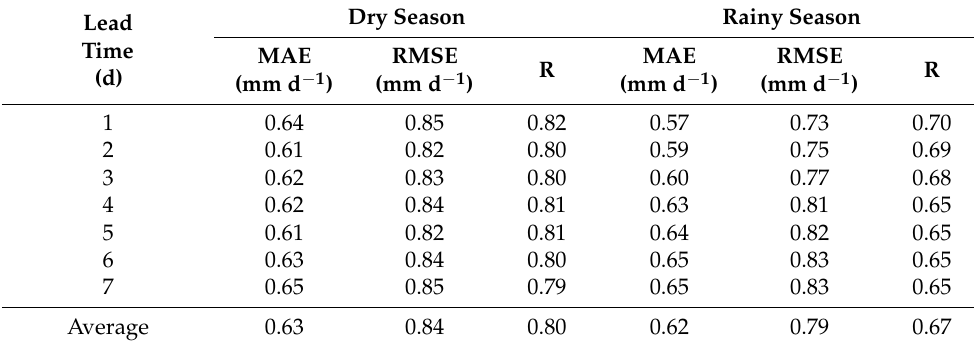
Table 5. Forecast accuracy of ET c in rubber plantations in